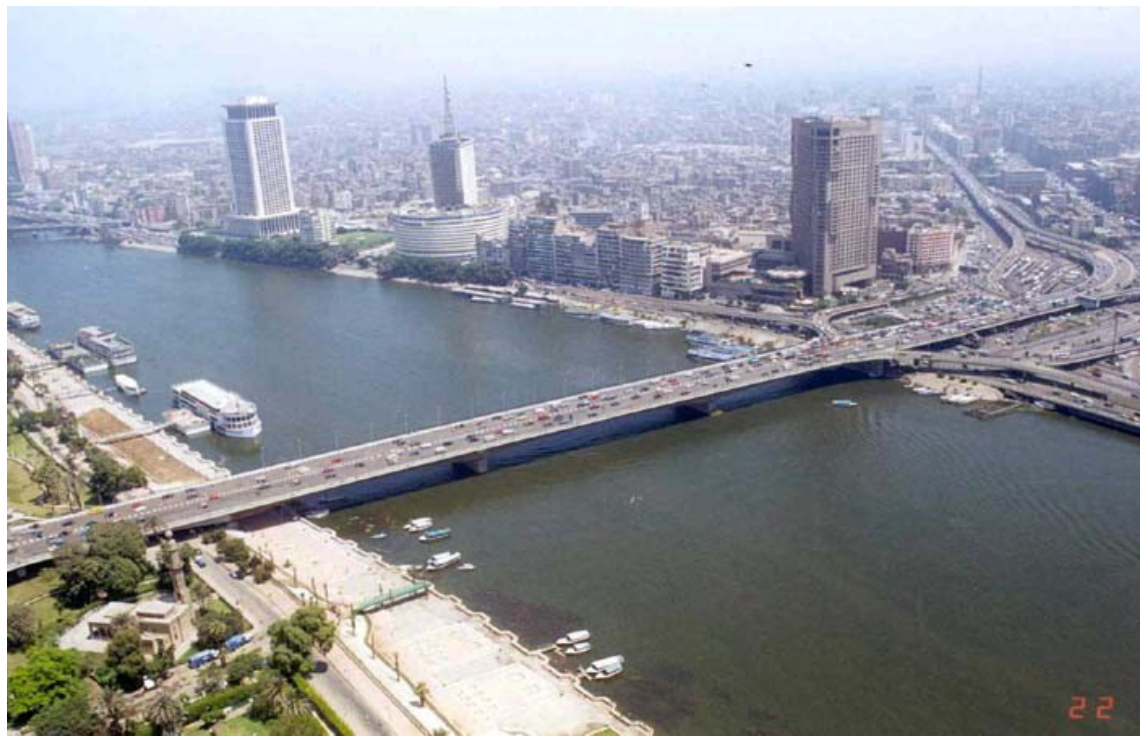
Figure 6. Bridge crossing theNile